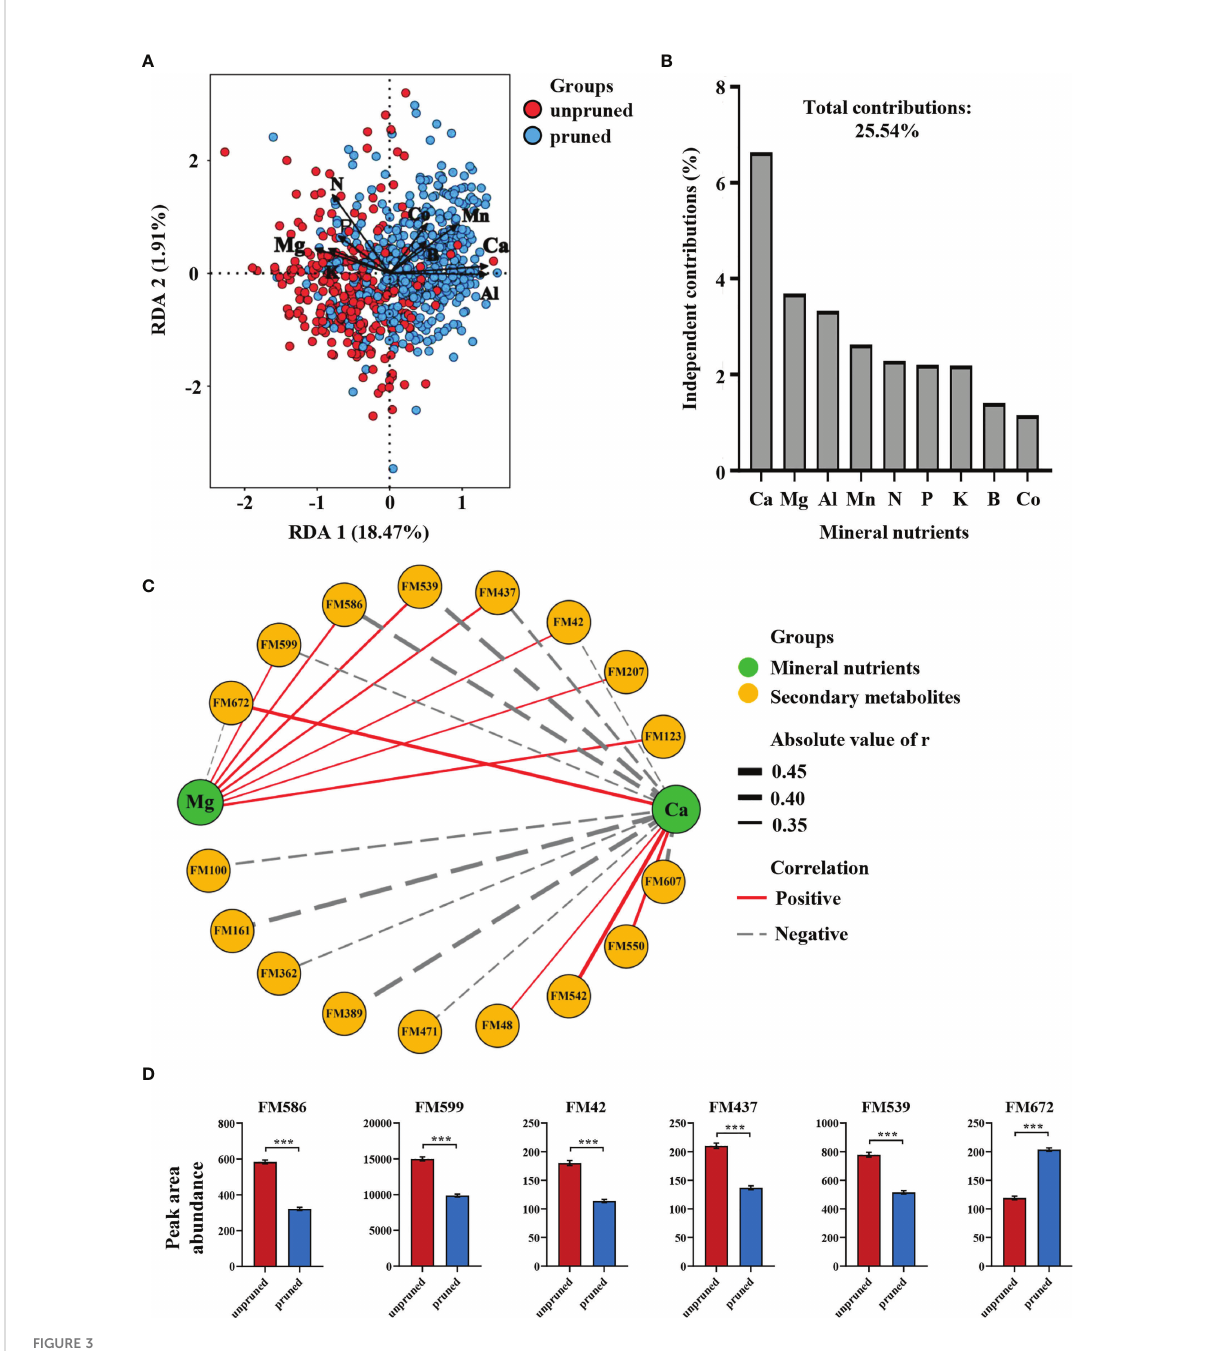
FIGURE 3 (A) Redundancy analysis of mineral elements and characteristic differential metabolites under pruned conditions. (B) Independent contributions of mineral elements on metabolite differences. (C) Correlation network analysis of calcium and magnesium with characteristic metabolites. (D) Key metabolites regulated by calcium and magnesium. Statistically signi fi cant differences between groups were tested by the Student ’ s t test. *** P ≤